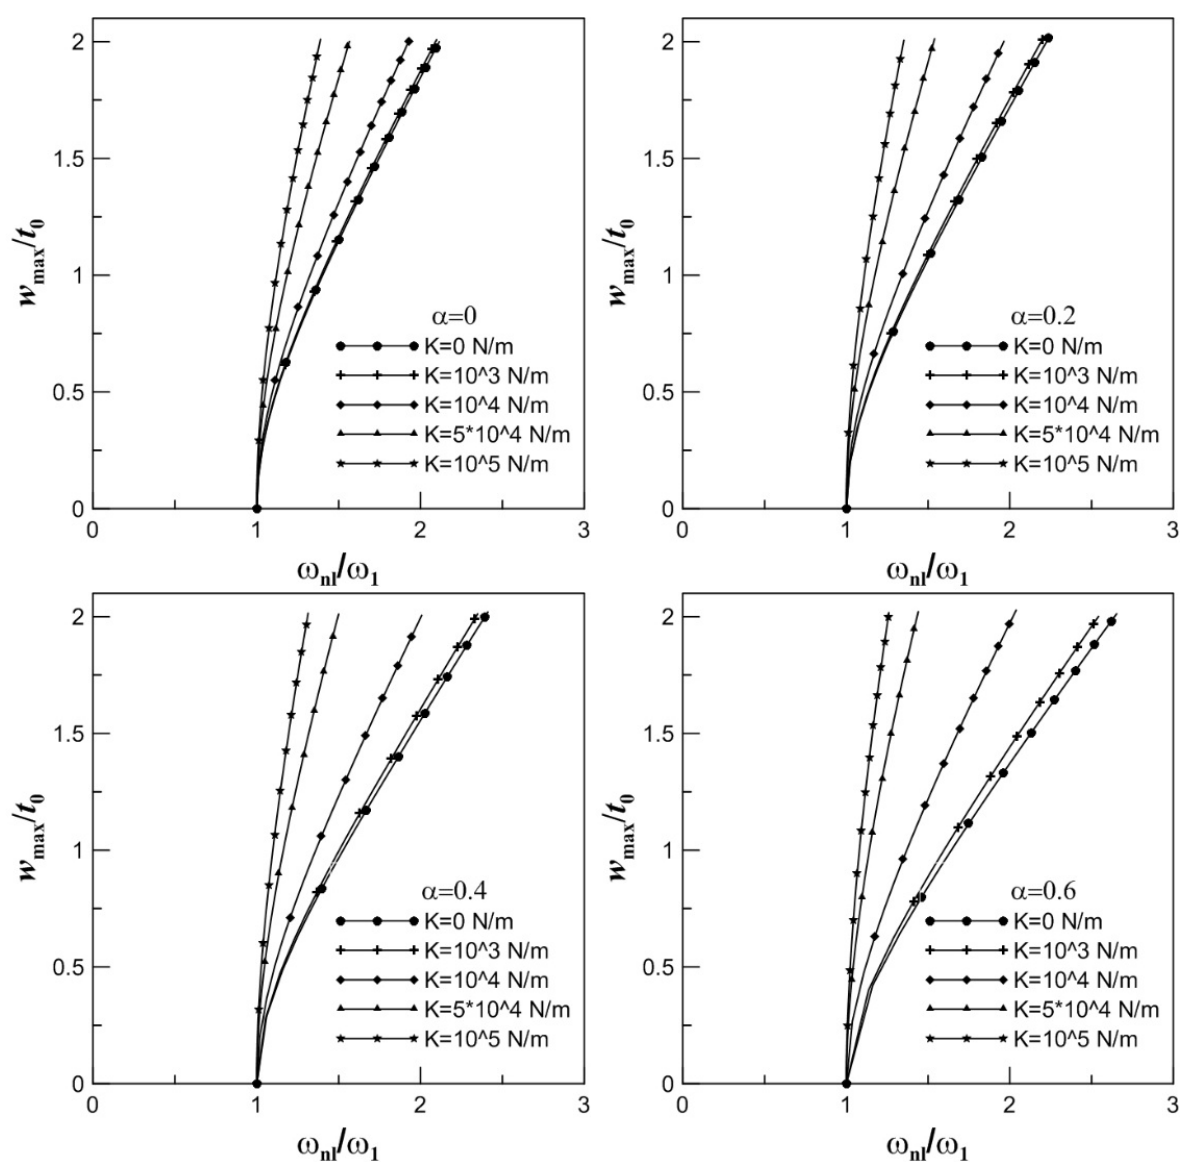
Figure 5: Backbone curve of AFG linear taper beam (︀ E ( ξ ) = E 0 e ξ , ρ ( ξ ) = ρ 0 e ξ )︀ on elastic